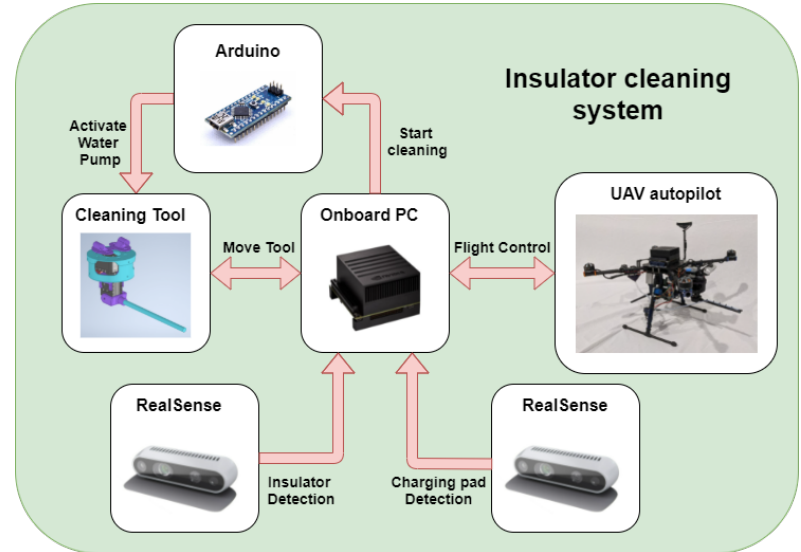
Figure 2. Conceptual scheme of the systems involved in the